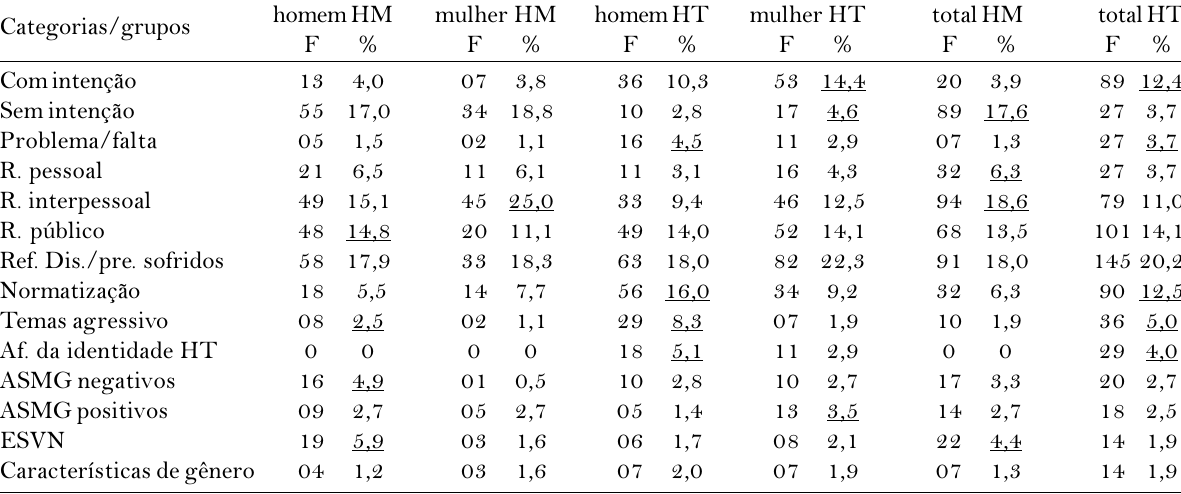
Freqüências e Percentagens Referentes à Questão de Associação Livre